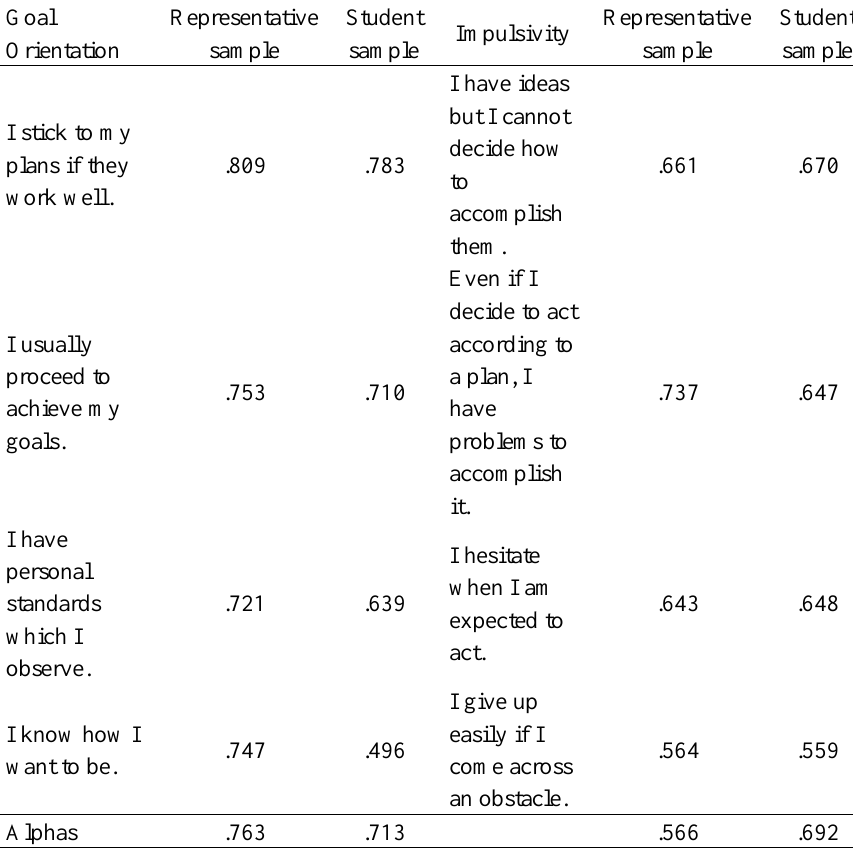
Table 2 Items of ScSRQ-CZ and factor loadings for the representative and the student